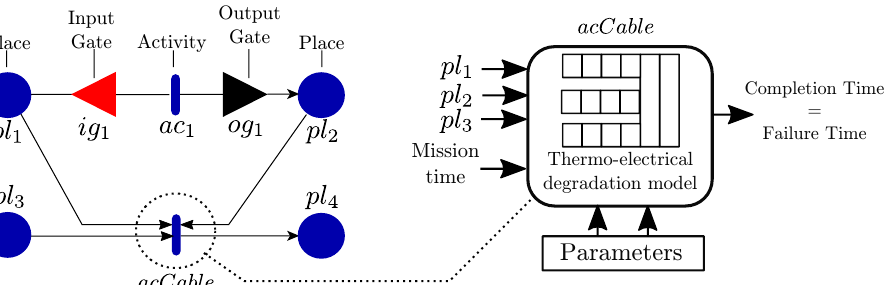
Figure 3. SAN model example with a cable thermo-electrical degradation model activity integrated within the